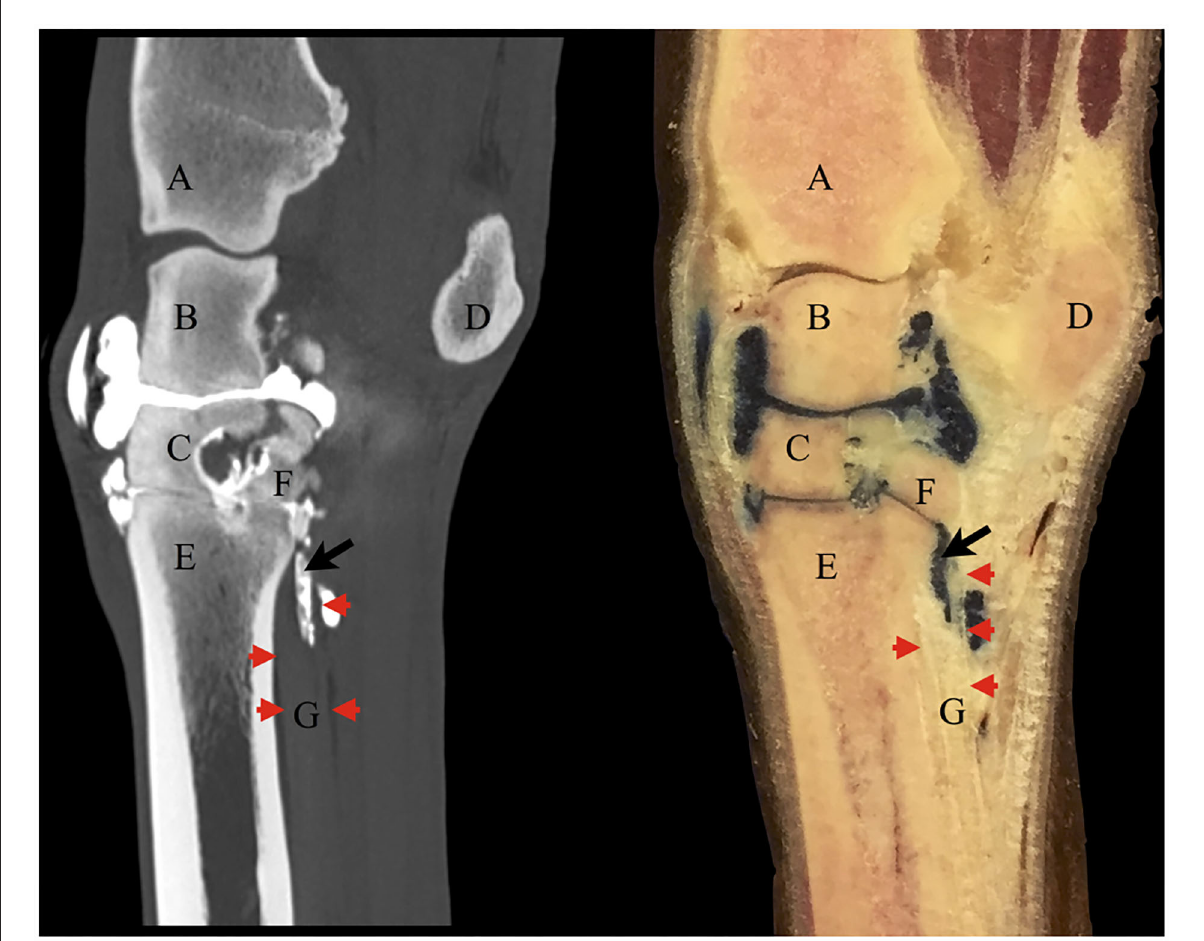
FIGURE4 Corresponding contrast CT arthrogram (left) and gross anatomy sagittal section specimen (right) following contrast/methylene blue mixture injection into the middle carpal joint of the same cadaver limb. The red arrowheads point out the dorsal (left) and palmar (right) borders of the origin of the suspensory ligament on both images. There is positive contrast medium on the CT image in the same location as the methylene blue mixture in the anatomical section within the ligament (black arrow). Some of the solution had leaked under the skin dorsal to the middle carpal joint at the injection site. (A) distal radius, (B) intermediate carpal bone, (C) third carpal bone, (D) accessory carpal bone, (E) third metacarpal bone, (F) fourth carpal bone, (G) suspensory ligament.